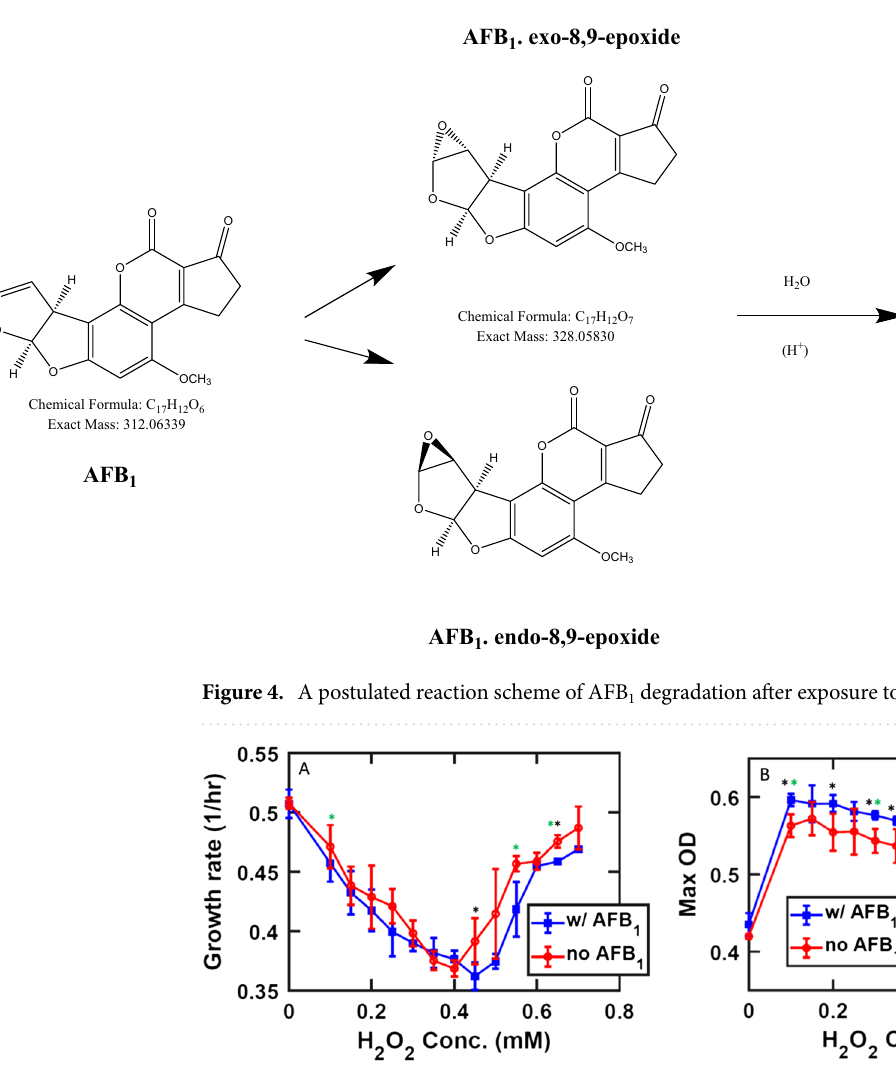
Figure 5. The red line represents control samples, the blue line the toxin-supplemented samples. Mean values are marked as circles, error bars are standard deviations calculated for the five experimental replicates under consideration. (A) Average of the growth rates at different H 2 O 2 intervals. (B) Average of maximum OD. The T test and the unparametrized Mann–Whitney test (MatLab Ranksum function) have been performed, the ‘*’ represent statistically significant data